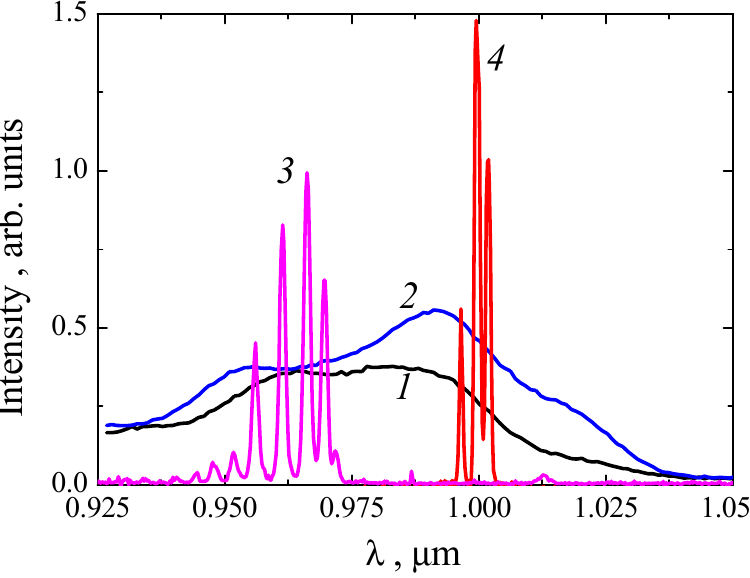
Figure 2. PL spectra of the samples A (1) and B (2) under cw pumping and also stimulated emission spectra of the samples A (3) and B (4).